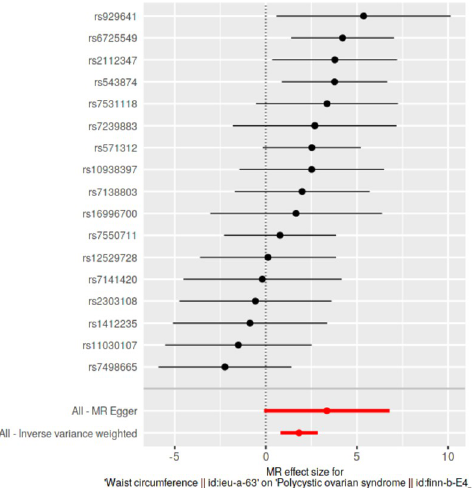
Fig 7. Forest plot of waist circumference, against polycystic ovarian syndrome as the outcome. Effects of individual SNPs and pooled estimates from MR-Egger- and inverse variance weighted methods are visualized.